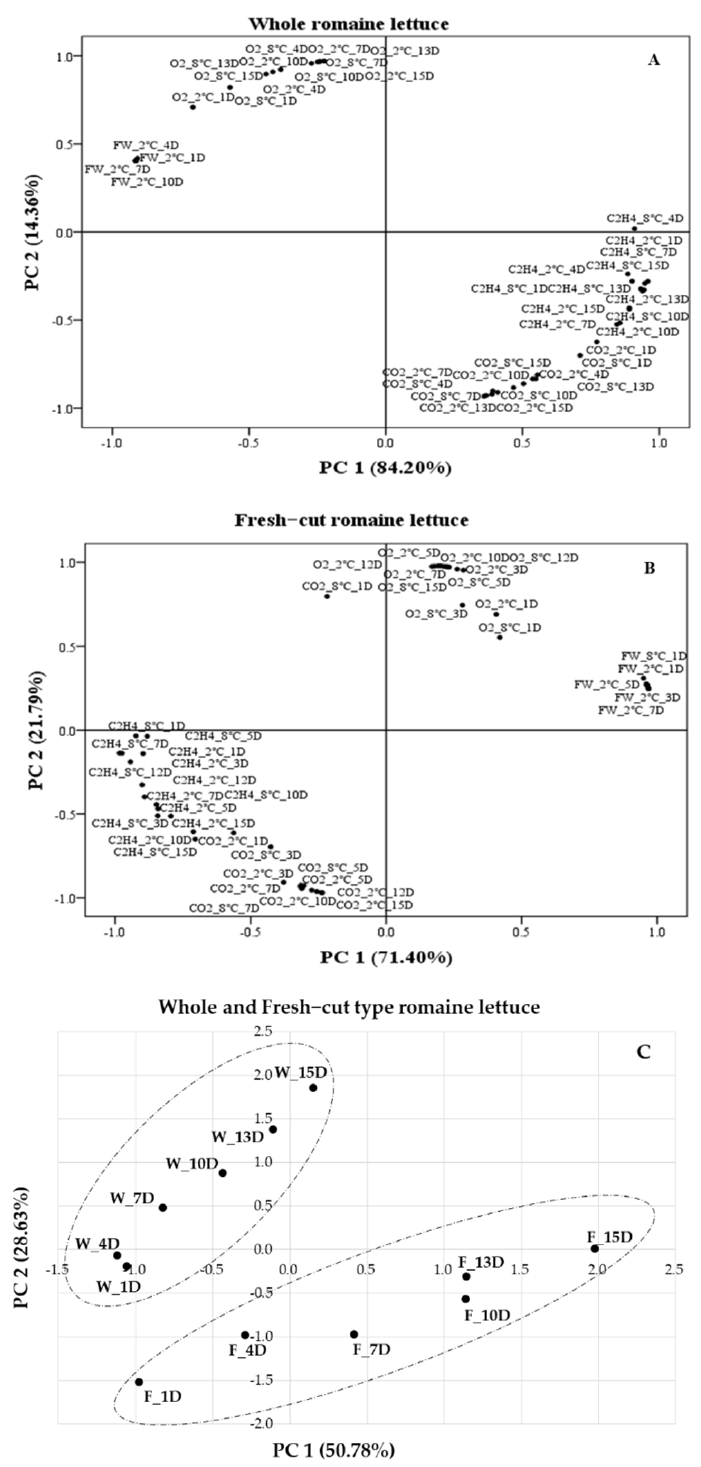
Figure 6. Plot of loadings ( A , B ) and scores ( C ) for the responses of type to whole and fresh-cut romaine lettuce during MA stored at 2 and 8 °C for 15 days from PCA. FW: fresh weight loss rate, O 2 : oxygen concentration, CO 2 : carbon dioxide concentration, and C 2 H 4 : ethylene concentration.